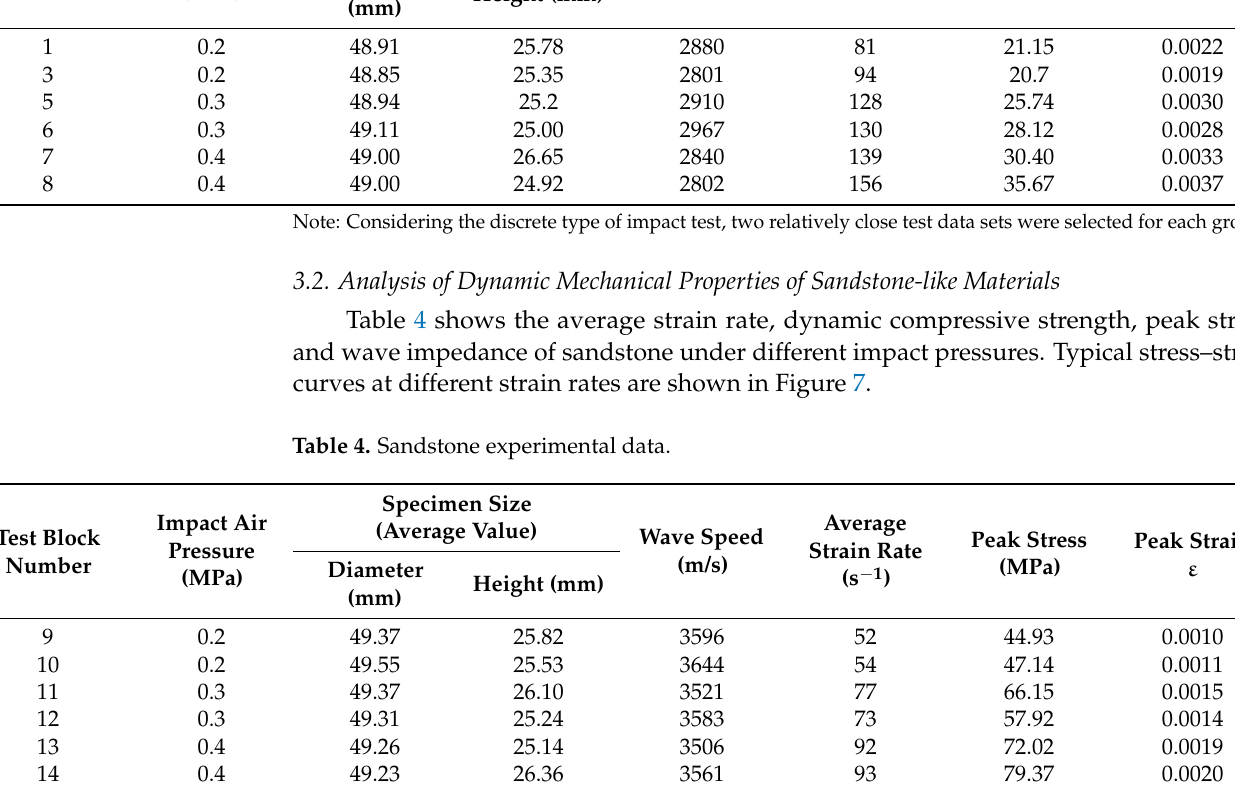
Table 3. Experimental data of mudstone−like materials.